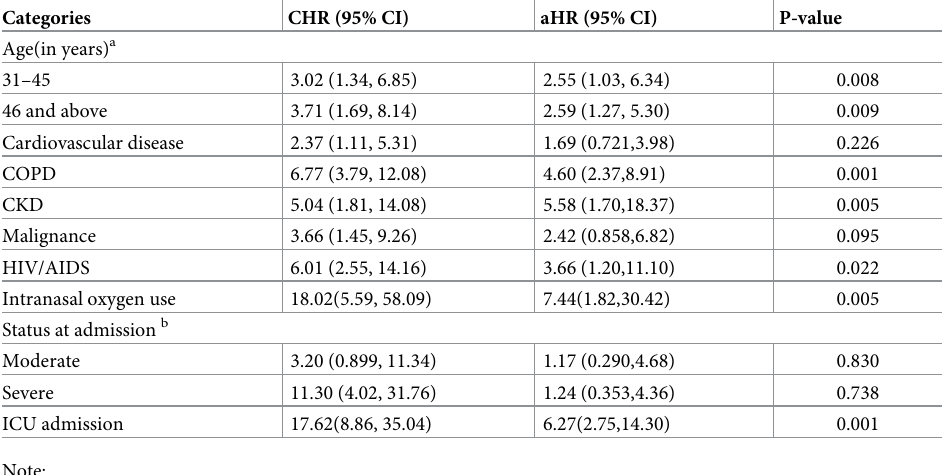
Table 4. Bivariate and multivariate Cox regression analysis of predictors of death among COVID-19 patients hos- pitalized at Bokoji Hospital treatment centre, Ethiopia,